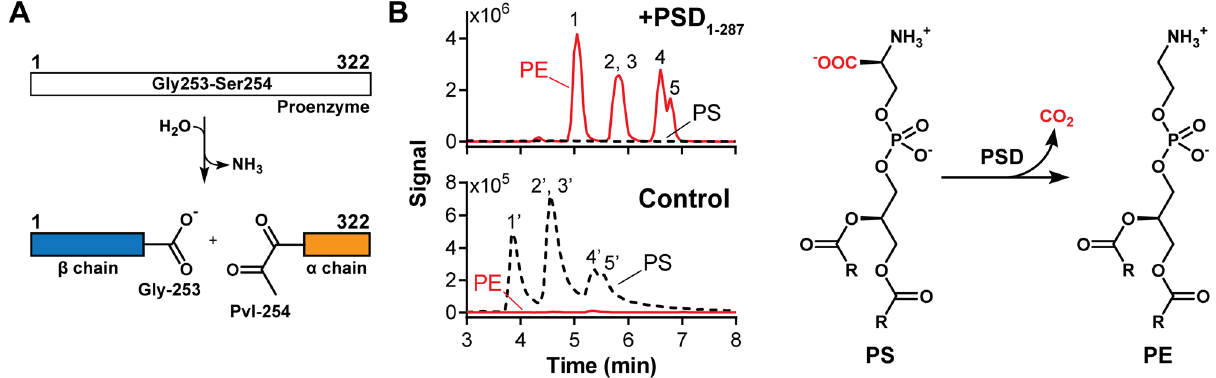
Figure 1. Auto-cleavage and PS decarboxylation activity of E. coli PSD. ( A ) A schematic of auto-cleavage. Pvl, pyruvoyl residue. ( B ) LC–MS analysis of PS decarboxylation by PSD 1–287 . Numbers in the chromatogram correspond to individual PE or PS molecular species: 1–5 represent 36:4, 34:2, 36:3, 34:1, and 36:2 PE (length of acyl-chain:degree of saturation), respectively; 1 ′ -5 ′ denote for equivalent acyl-chain PS. Scheme of PS decarboxylation is shown on the